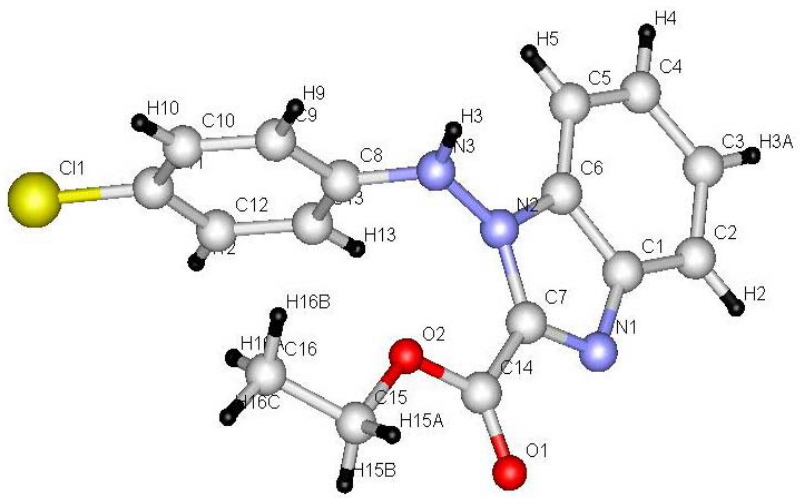
Figure 4. Ball and stick drawing of 14b .